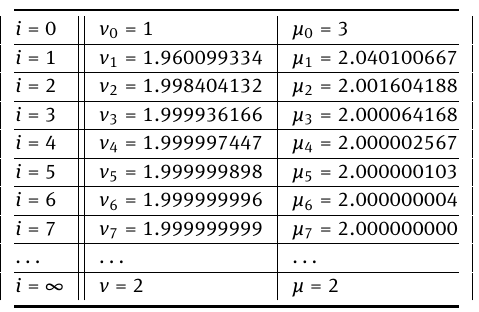
Table 1: Convergence of iterative